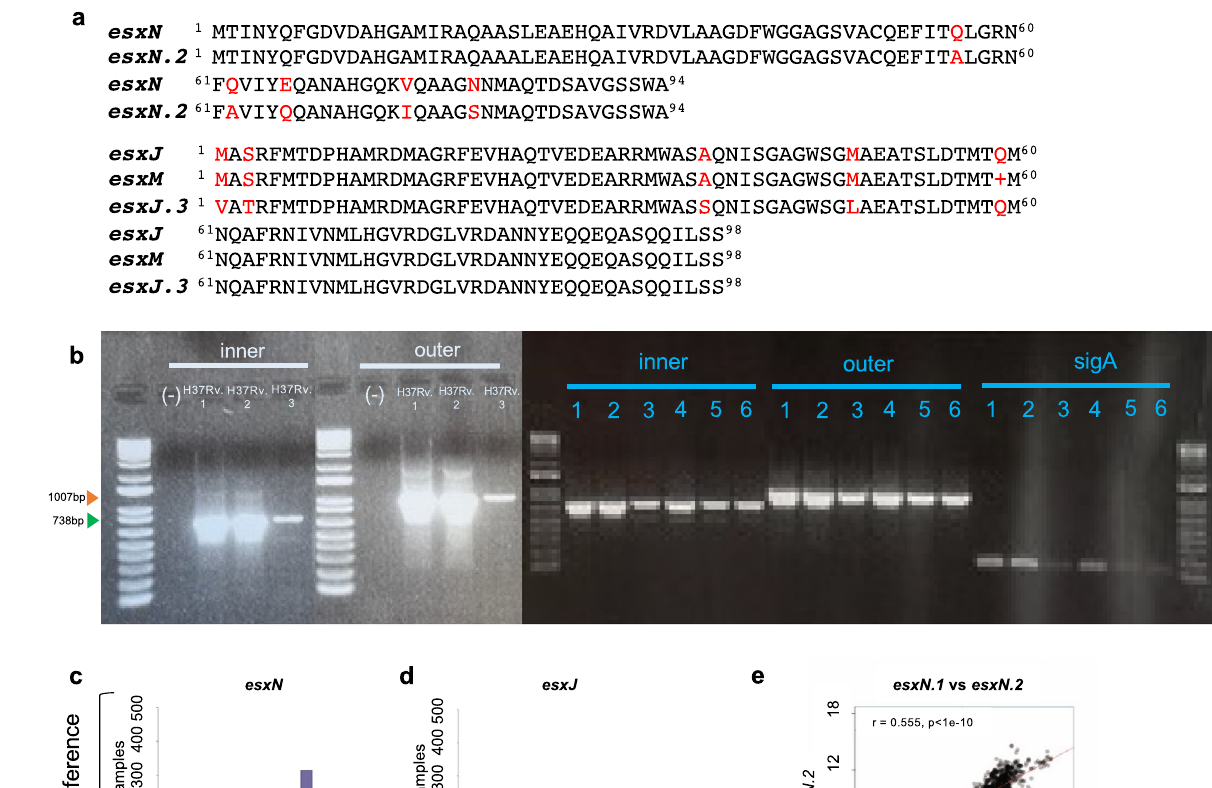
Histogram of esxN ( c ) and esxJ ( d ) expression in public H37Rv datasets, demon- strating that newly identi fi ed esxN.2 and esxJ.3 are expressed in H37Rv and exhibit differential gene expression compared to their respective paralogs. e-g Scatter- plots showing correlation of expression using Pearsons correlation coef fi cient in H37Rv (new) of esxN.1 and esxN.2 (r=0.554; p=7.02e-75) ( e ); esxJ.1 and esxJ.3 (r=0.526; p =1.41e-65) ( f ); and esxN.2 and esxJ.3 (r=0.778; p =2.04e-195) ( g